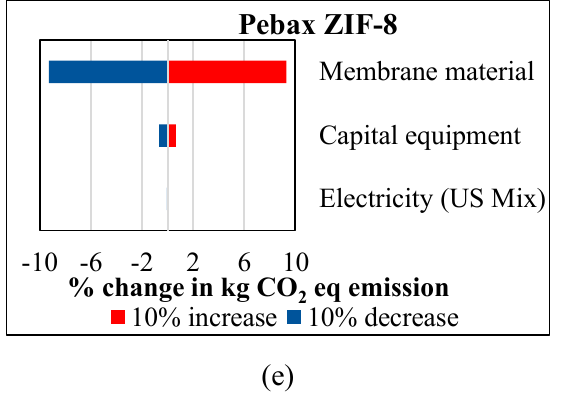
Figure 7. Sensitivity analysis of GWP by increasing and decreasing by 10% membrane material, capital equipment, and electricity requirements of ( a ) MEEP, ( b ) MEEP/CN, ( c ) Pebax LE, ( d ) Pebax HE, and ( e ) Pebax ZIF-8 membrane processes.